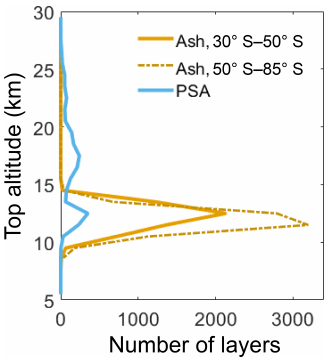
Figure 17. Top altitudes for layers classified as ash and PSA during 15–28 June